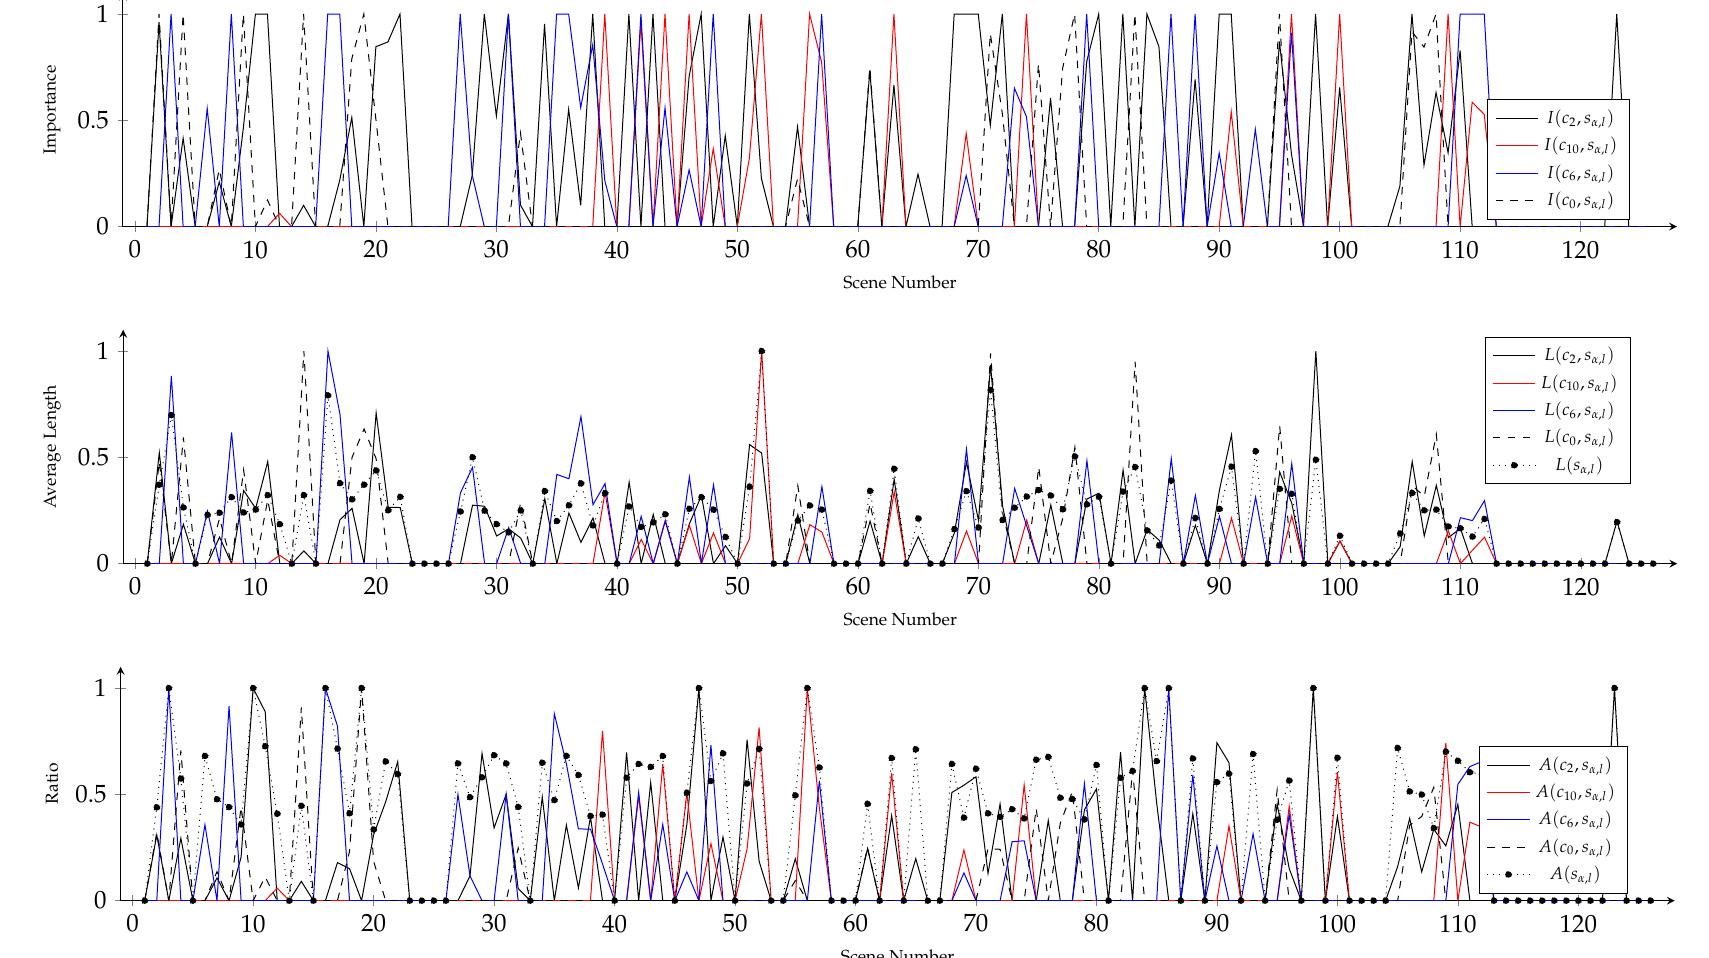
Figure 3. An example of fluctuations in the proposed features according to narrative time within ‘Good Will Hunting’ (1997). c 2 , c 10 , c 6 , and c 0 indicate ‘Will’, ‘Sean’, ‘Lambeau’, and ‘Chuckie’, respectively. ‘Will’ is the protagonist of this movie, and the others are the main characters, in terms of their centrality [2,11]. Identifiers of the characters are assigned according to the order of their initial appearances. I ( c i , s α , l ) , L ( c i , s α , l ) , and A ( c i , s α , l ) are defined in Definitions 3, 4, and 5,